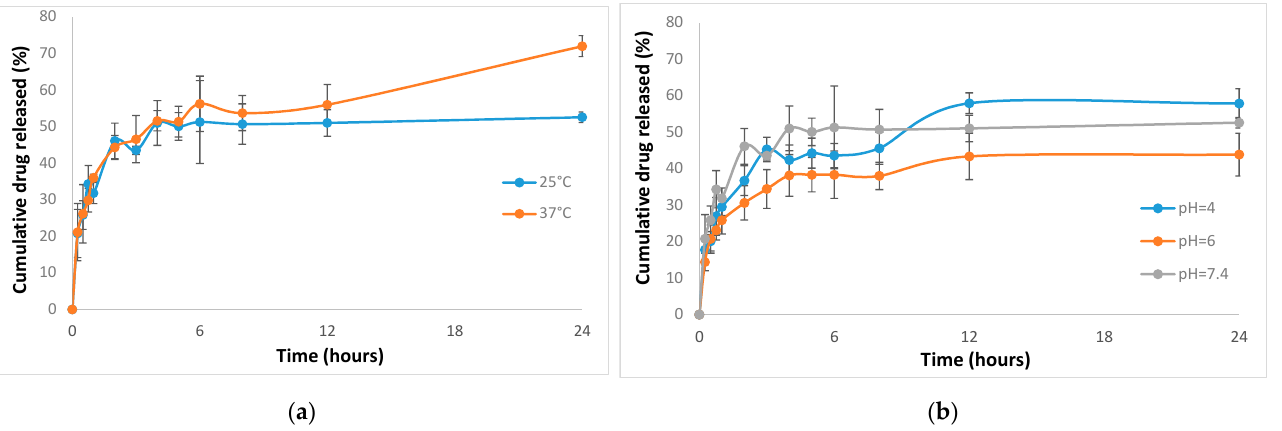
Figure 5. In vitro drug release profile for NFLX in mixed CrEL-Pl F127 ( α = 0.2) micelles at various temperature ( a ) and pH values ( b ).